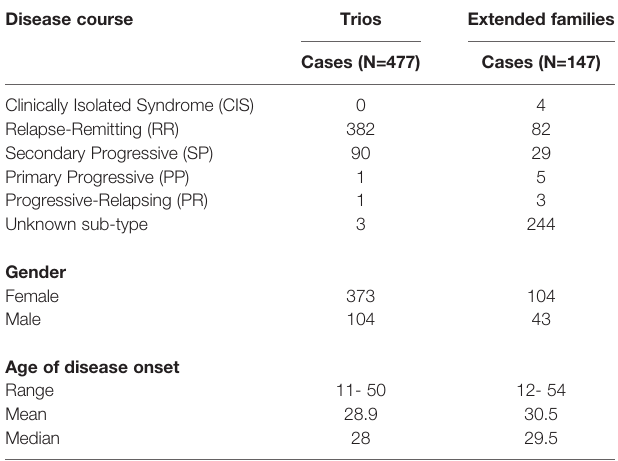
Table contains “ Disease course ” , “ Gender ” and “ Age of disease onset ” information. “ Trio ” column shows demographic information about MS cases (children) from 477 trio families. “ Extended families ” column shows demographic information about MS cases from 54 extended families in which the numbers of MS patients ranged from 2 to